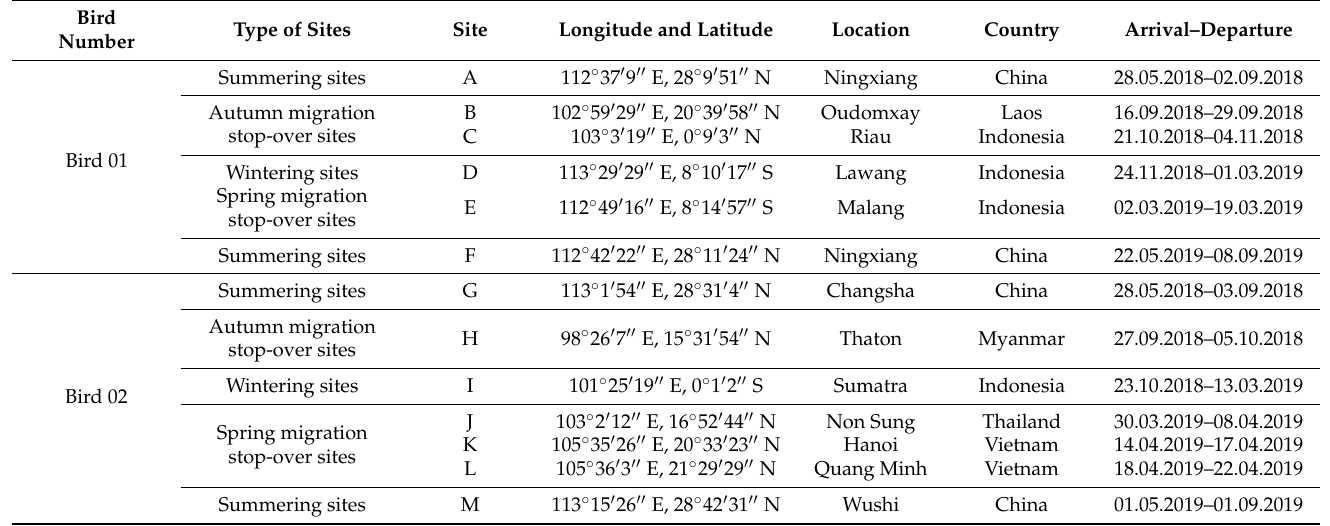
Table 2. A date overview of the locations of Chinese Sparrowhawks 01 and 02 during the entire GPS satellite tracking. Bird Type of Sites Site Longitude and Latitude Location Number